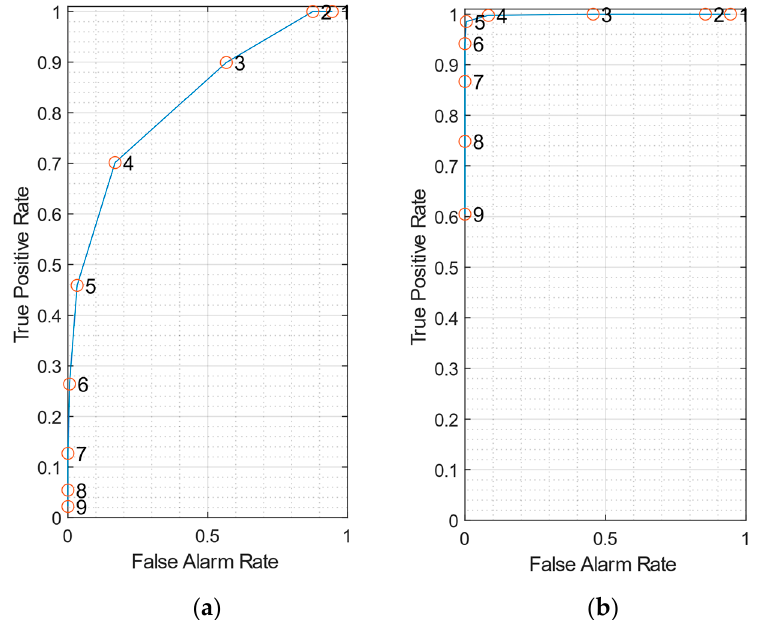
Figure 5. ( a ) receiver operating characteristic ( ROC ) curve using data from a single pixel of the multi transistor arrays (MTA), for SNR = 3 dB. ( b ) ROC curve exploiting the correlation between signals coming from the 7 honeycomb pixels is exploited, for SNR = 3 dB. In both plots, true-positive and false-alarm rates are averaged on 10 datasets.